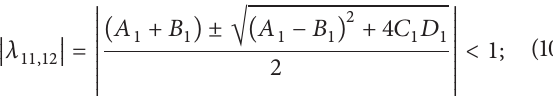
And the characteristic equation